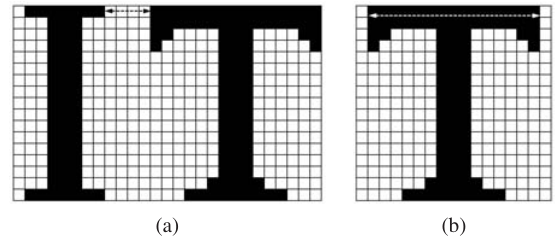
Figure 3. Illustration of shortest background run-length ( s ) and longest foreground run-length ( l ) inside text regions. (a) Shortest background run-length is 4 as the smallest gap between two horizontally adjacent characters is 4 pixels. (b) Longest foreground run-length is 15 as there are 15 pixels horizontally adjacent to each